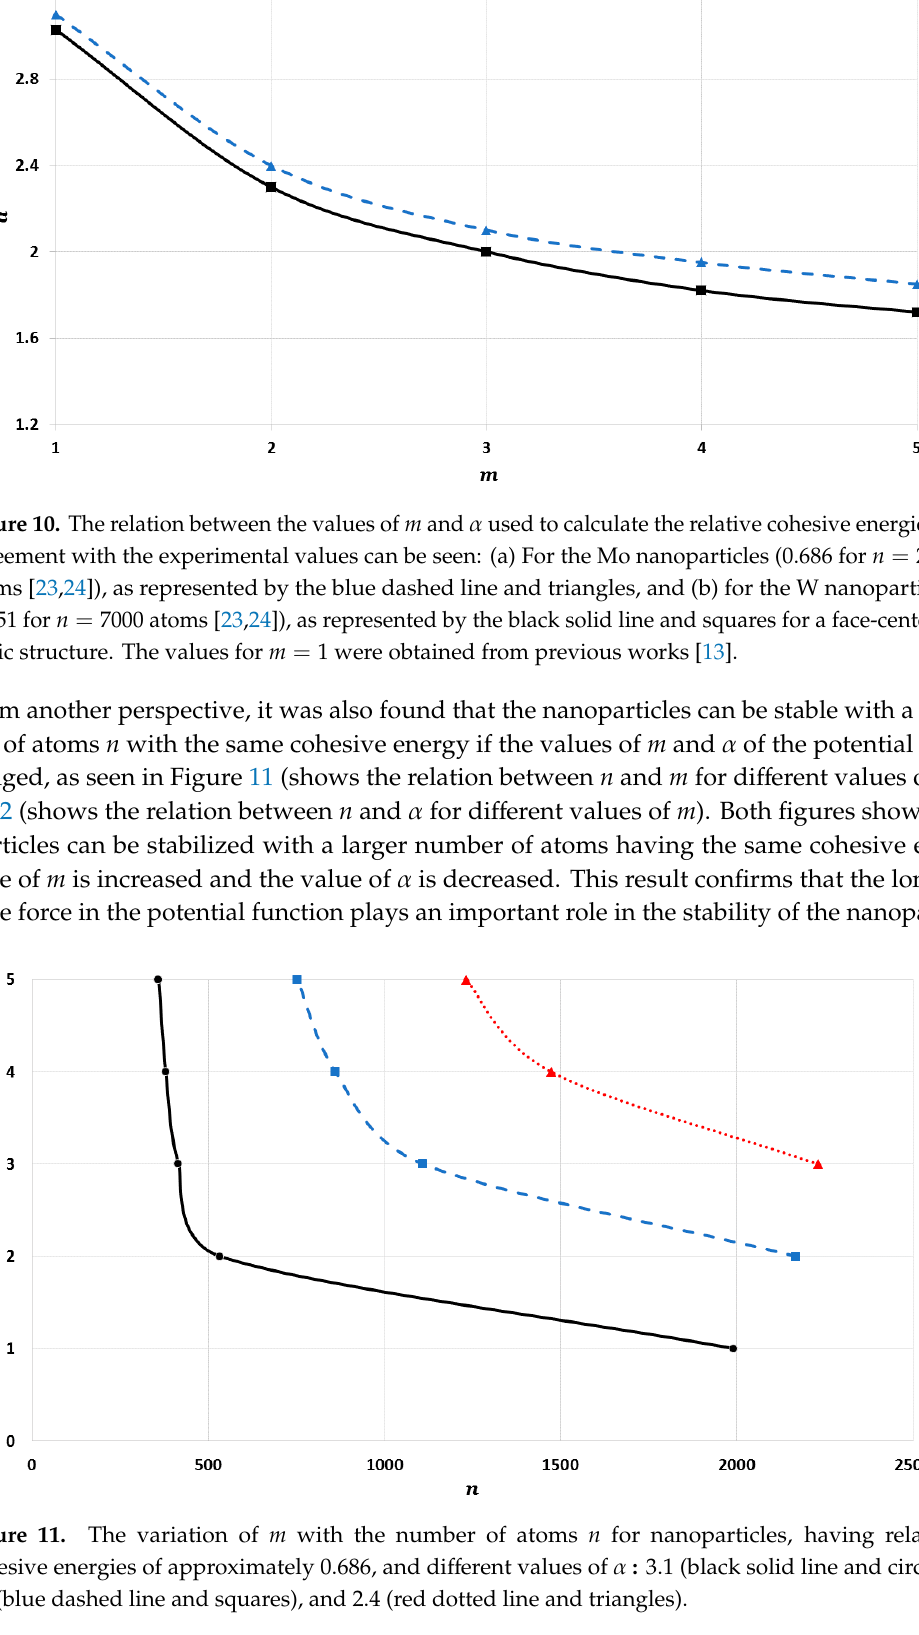
Figure 9. The variation of the relative cohesive energy of nanoparticles in a face-centered cubic structure as function of the number of atoms for (cid:1865) = 4 and different values of (cid:2009) : 2.05 (black solid line), 1.95 (blue dashed line), and 1.85 (red dotted line). The experimental values [23,24] are denoted by dark blue circles.